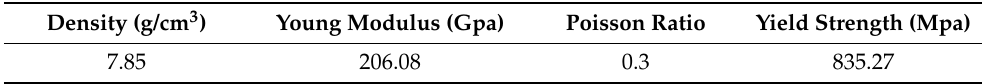
Figure 12. Stress and strain curve of the VCSB material. Table 4. Material parameters of variable cross-section